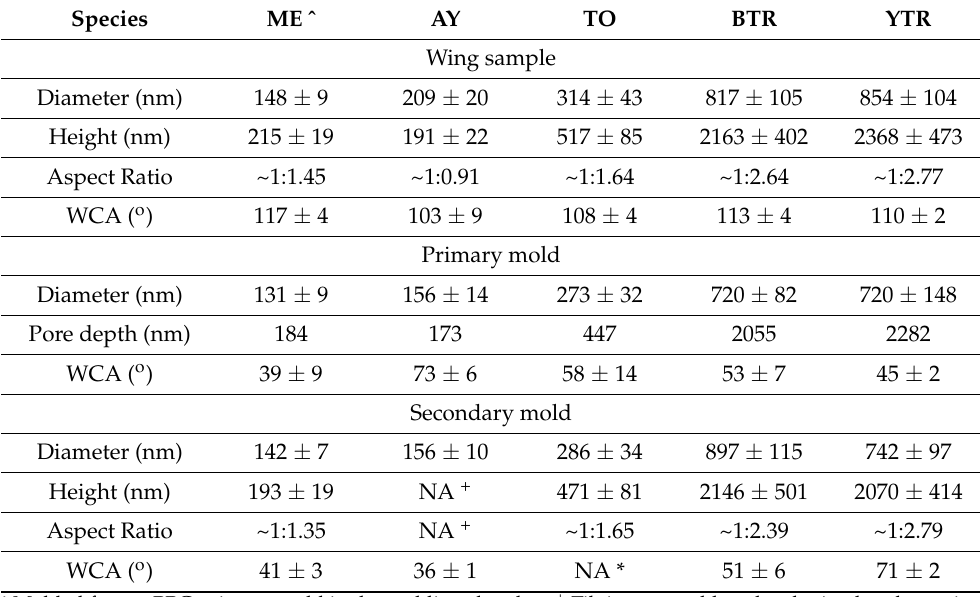
Table 1. Feature sizes and water contact angles (WCAs) for the wings, primary molds, and